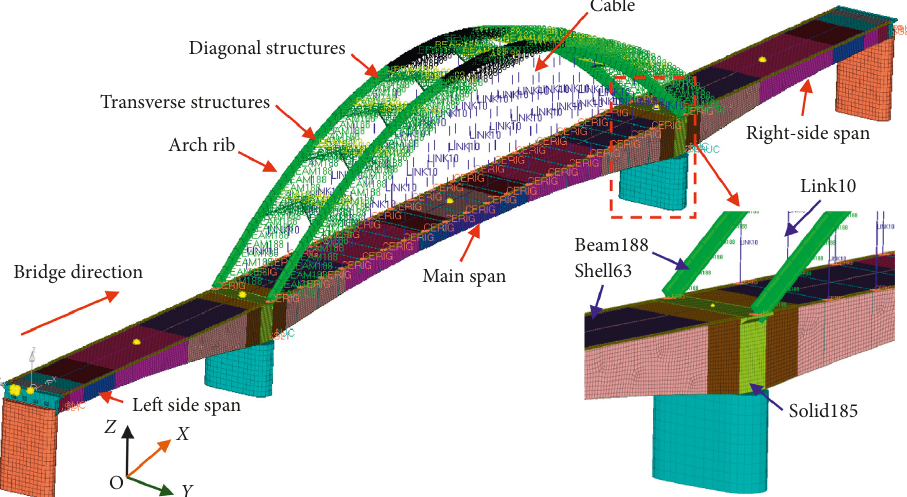
Figure 16: 3D FE model of the Chengjiang bridge.